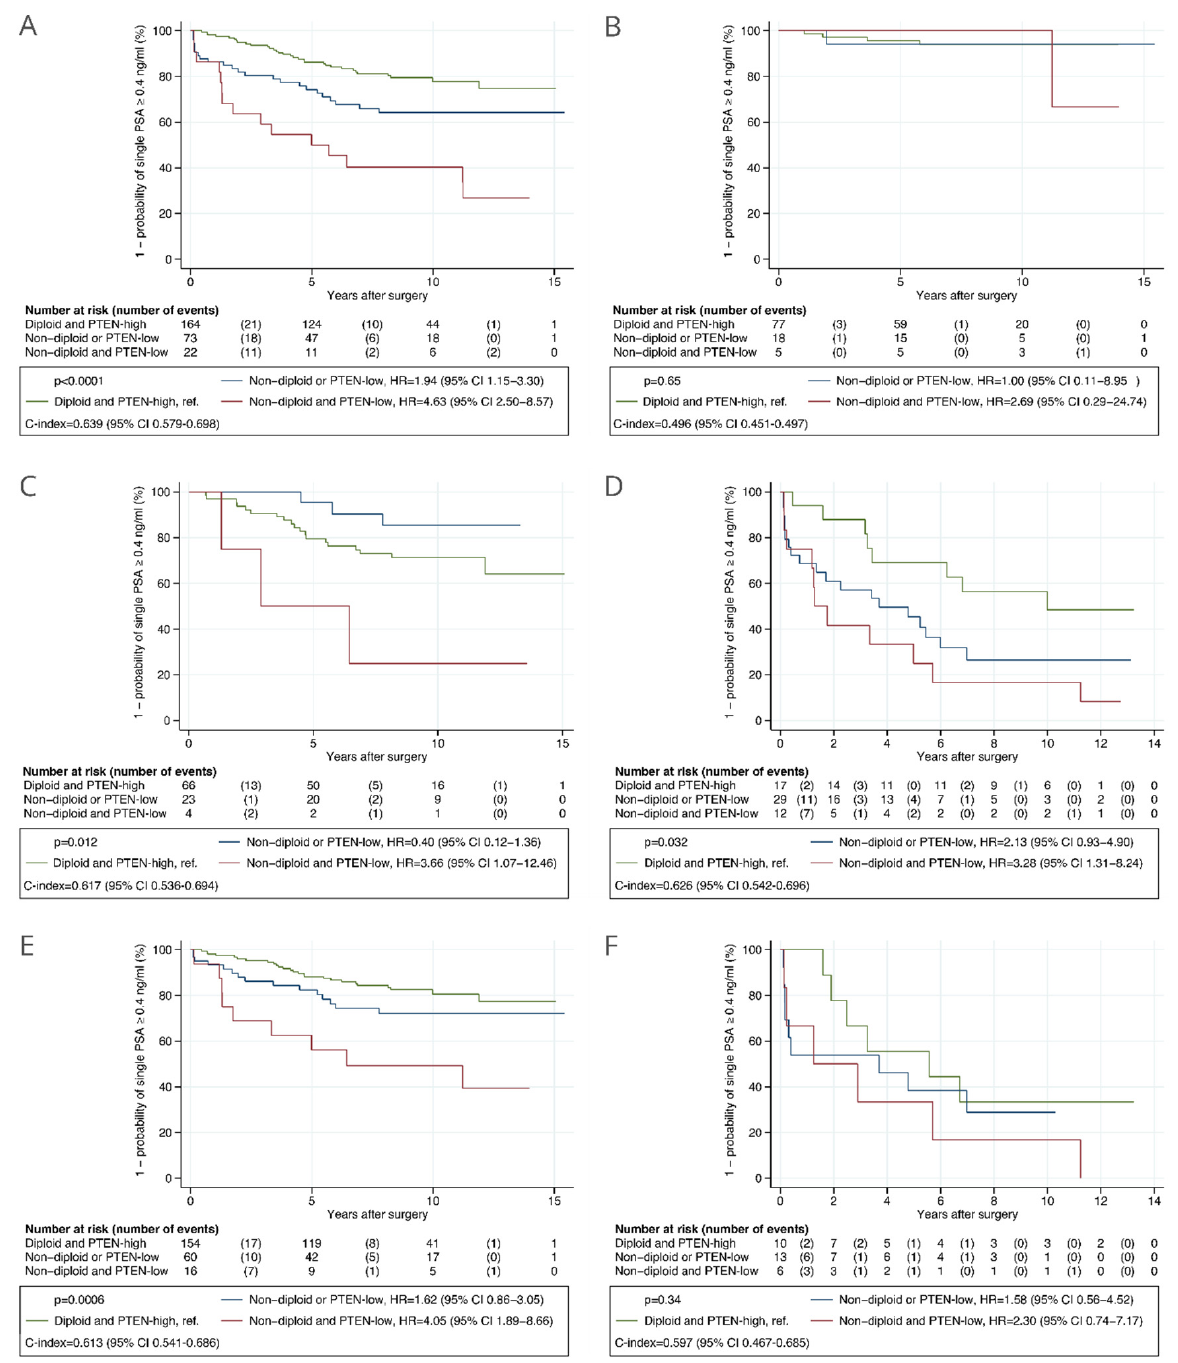
Figure 4. Kaplan–Meier analysis of time to biochemical recurrence after radical prostatectomy stratified by the combined automatically assessed PTEN and DNA ploidy status in the validation cohort. ( A ) All patients. ( B ) Patients with low risk as given by CAPRA-S score. ( C ) Patients with intermediate risk as given by CAPRA-S score. ( D ) Patients with high risk as given by CAPRA-S score. ( E ) Patients with GGG ≤ 3 tumors. ( F ) Patients with GGG > 3 tumors. Routine Gleason scores were used in the analyses. Abbreviations: CAPRA-S = Cancer of the Prostate Risk Assessment Post-Surgical score; C-index = concordance index; CI = confidence interval; GGG = Gleason grade group; HR = hazard ratio; PTEN = phosphatase and tensin